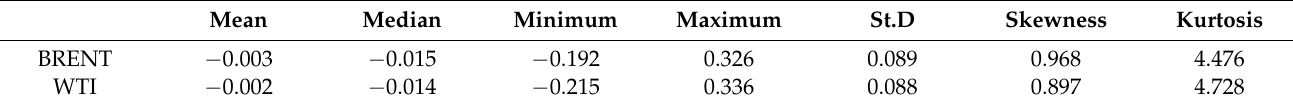
Table 1. Summary